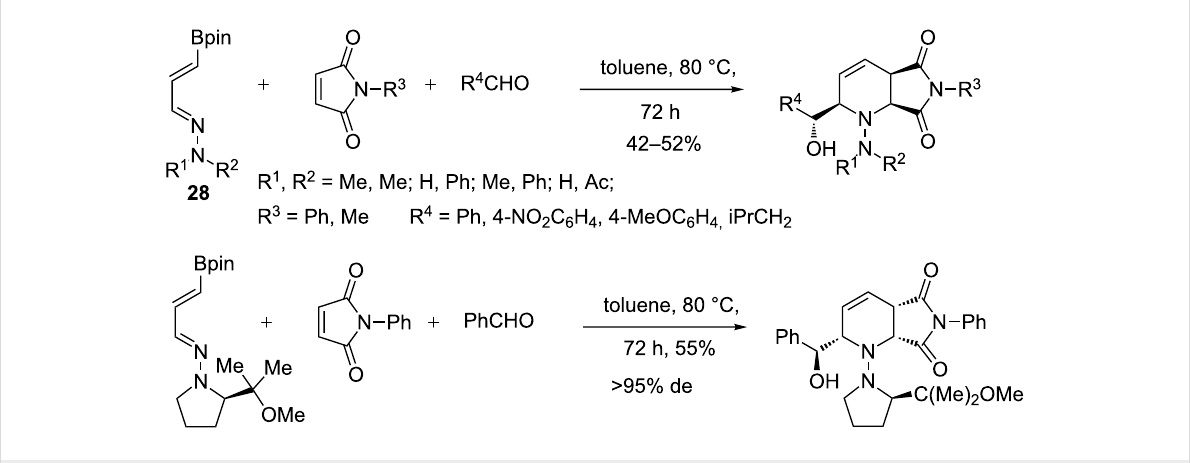
Scheme 21: Bicyclic piperidines from tandem aza-[4 + 2]-cycloaddition/allylboration.